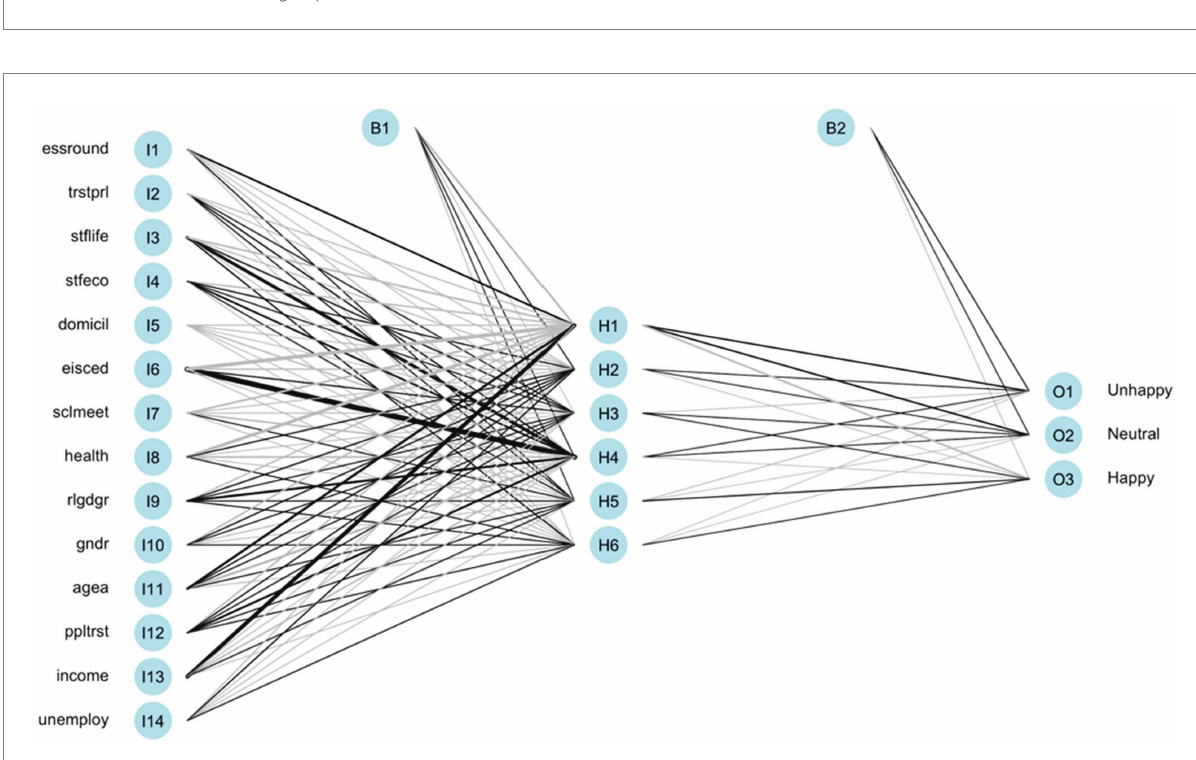
FIGURE 3 Trained ANN of the total native group.